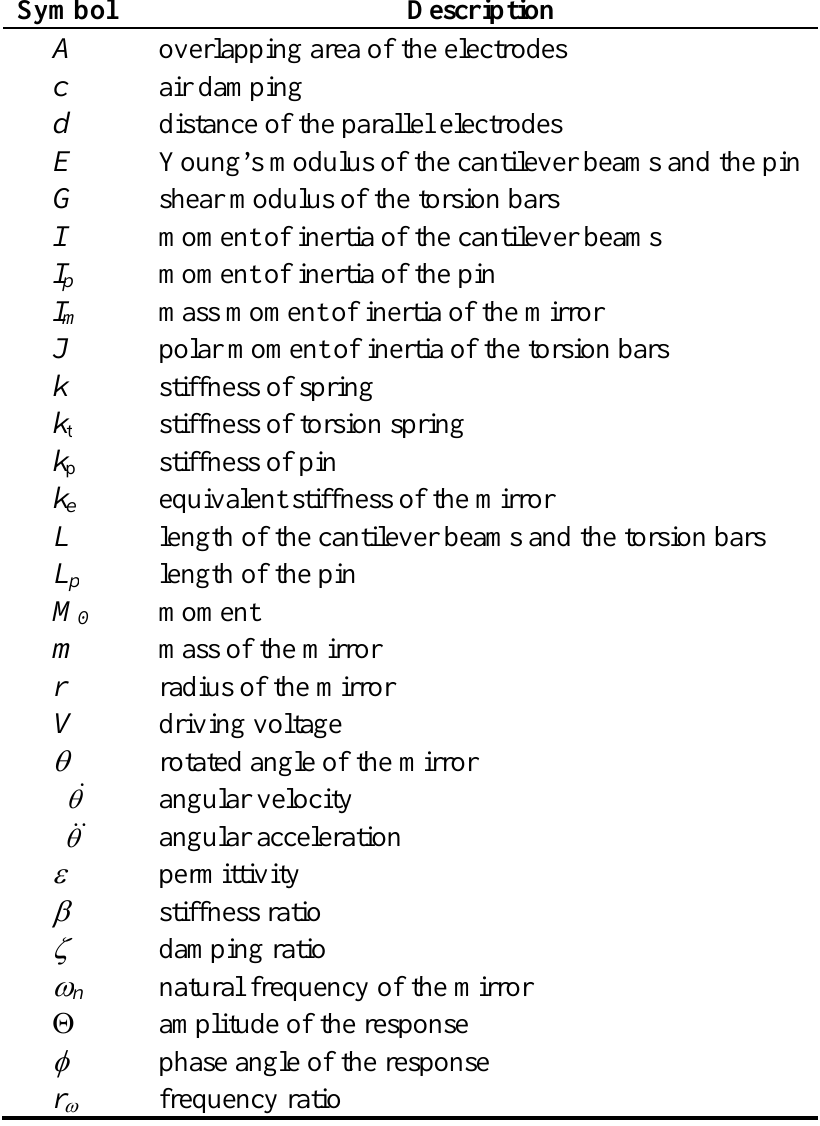
Table 1. List of symbols.